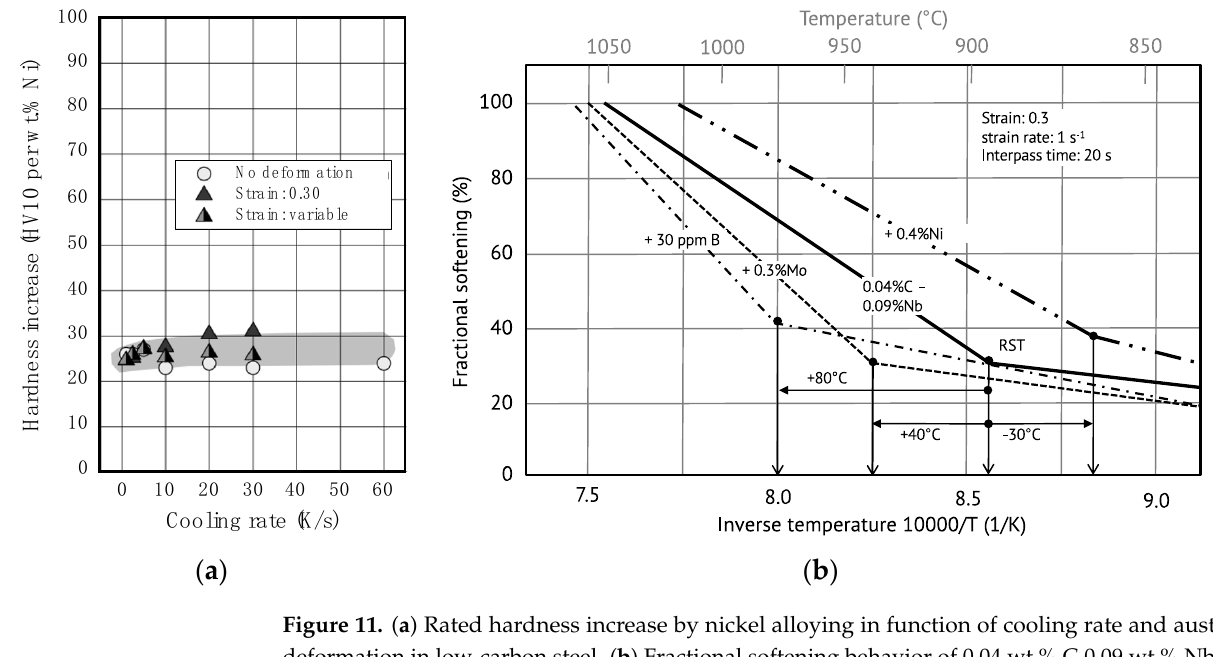
Figure 11. ( a ) Rated hardness increase by nickel alloying in function of cooling rate and austenite deformation in low ‐ carbon steel. ( b ) Fractional softening behavior of 0.04 wt.% C 0.09 wt.% Nb steel during simulated austenite deformation (measure by hot torsion testing) and influence of additional alloying elements Mo and B (RST: recrystallization ‐ stop temperature).